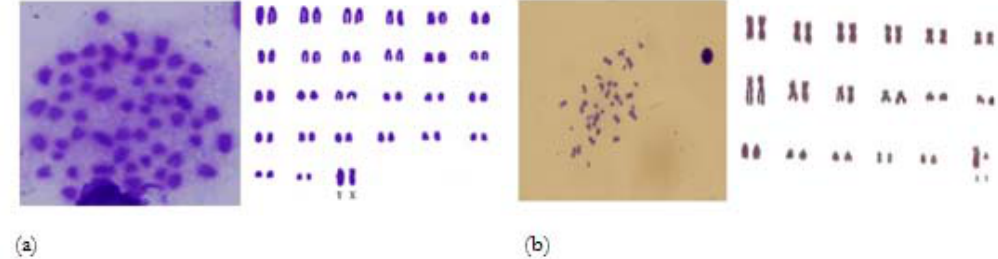
F IGURE 6. Metaphase spreads and idiograms of the genus Ellobius . (a) E. talpinus (b) E. fuscocapillus